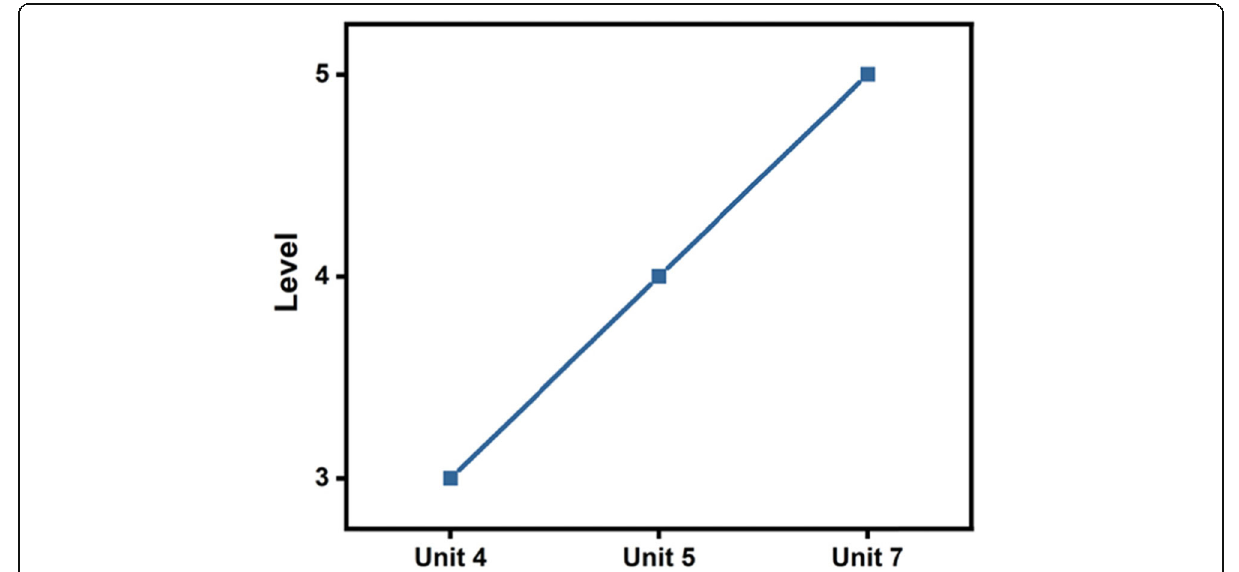
Fig. 4 The change trend of “ understanding of core ideas ”